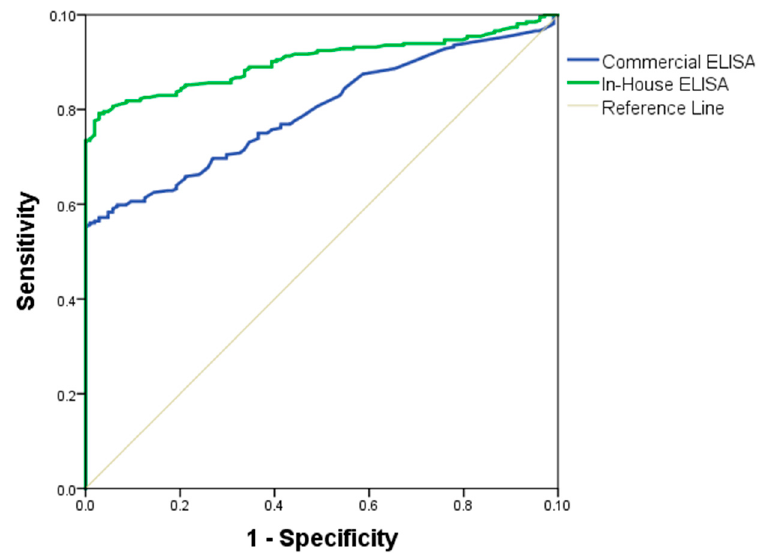
Figure 4. ELISA receiver operating characteristic (ROC) curves. Absorbance of sera samples obtained by in-house and commercial ELISAs were plotted and ROC curves generated. Blue line represents the sensitivity to commercial ELISA, green line represents the sensitivity of in-house ELISA, and black line represents the specificity. The area under the curve was determined with a 95% confidence interval. Table 2. Parameters of area under curve (AUC)—ROC curves of commercial ELISA and in-house ELISAs.